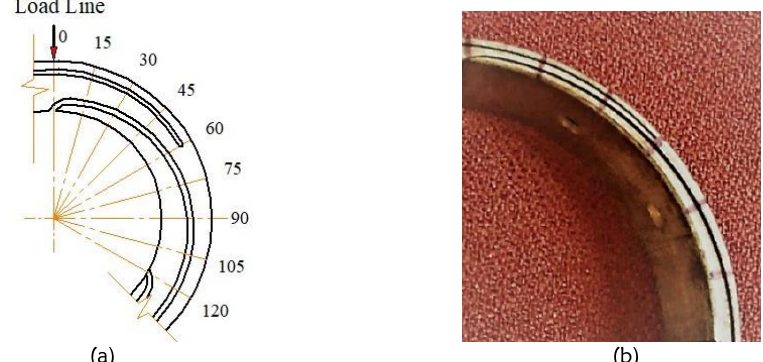
Figure 5: (a) Graphical representation of load line & marking of angular positions for 3-grooves ISSFD ring with 180° groove angle and (b) Photograph of a ring with marked angular positions